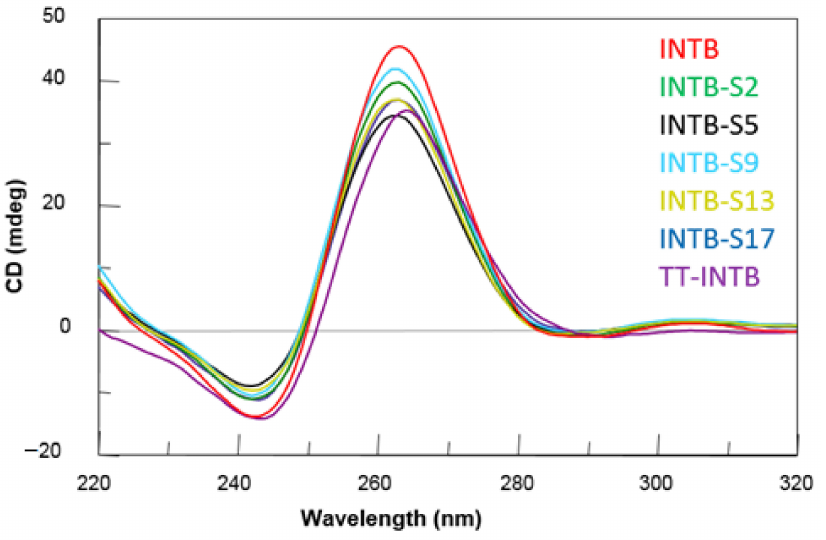
Figure 3. CD spectra of the T30175 analogues investigated. See Section 3 for experimental